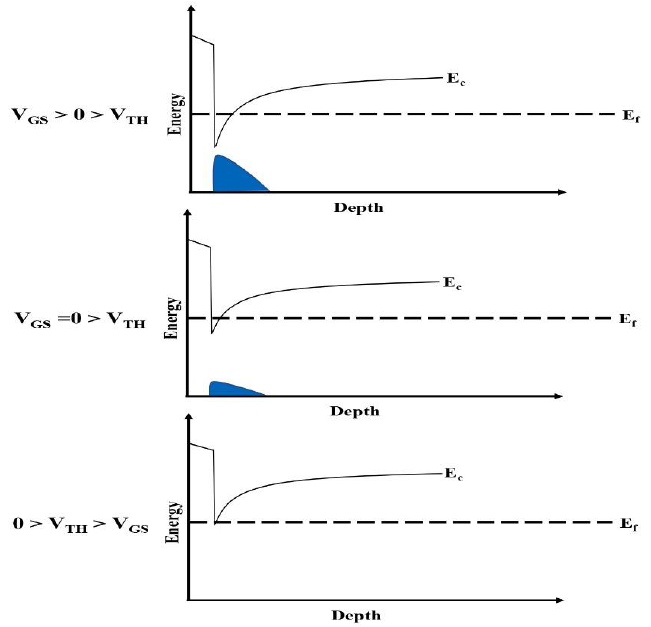
Figure 15. The band diagrams for the three locations of the 2DEGs V GS > 0 >V TH , V GS = 0 > V TH and 0 > V TH > V GS.